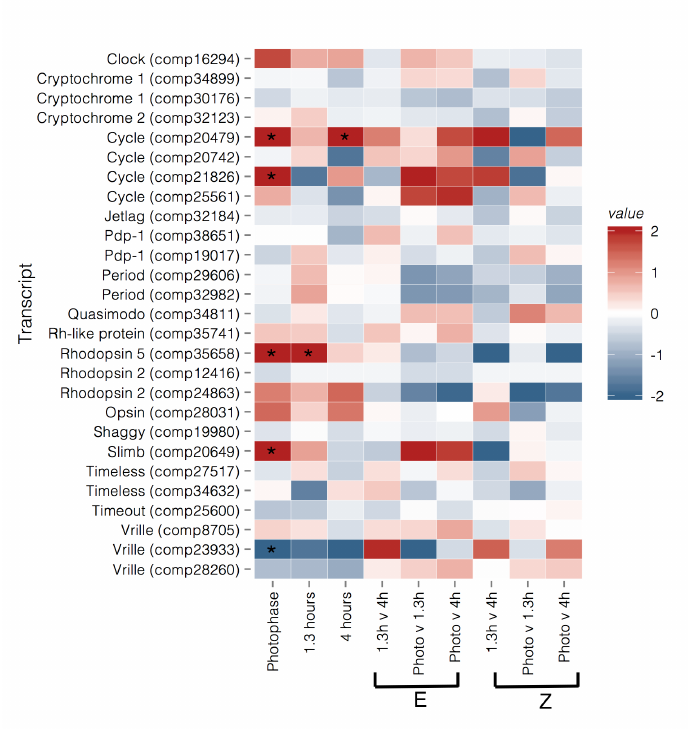
Figure 4. Heatmap of relative expression of genes in the circadian pathway and related photoreceptors in each contrast. Values are log FC. Photophase, 1.3 h, and 4 h contrasts are between strain with red indicating upregulation in BE (early daily and seasonal mating), and blue indicating upregulation in UZ (late daily and seasonal mating). For within strain/between time point contrasts the red color indicates upregulation at the first time point, and blue color indicates upregulation at the second time point. Log FC were capped to a minimum of − 2 and a maximum of 2 for visualization purposes. Asterisks indicate genes that are significantly differentially expressed ( q -value < 0.05) for a given